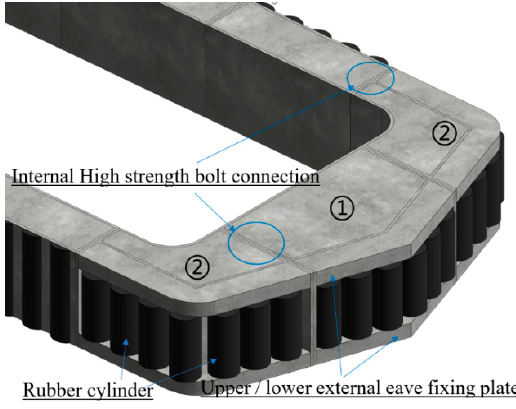
Figure 2. Device end structure.